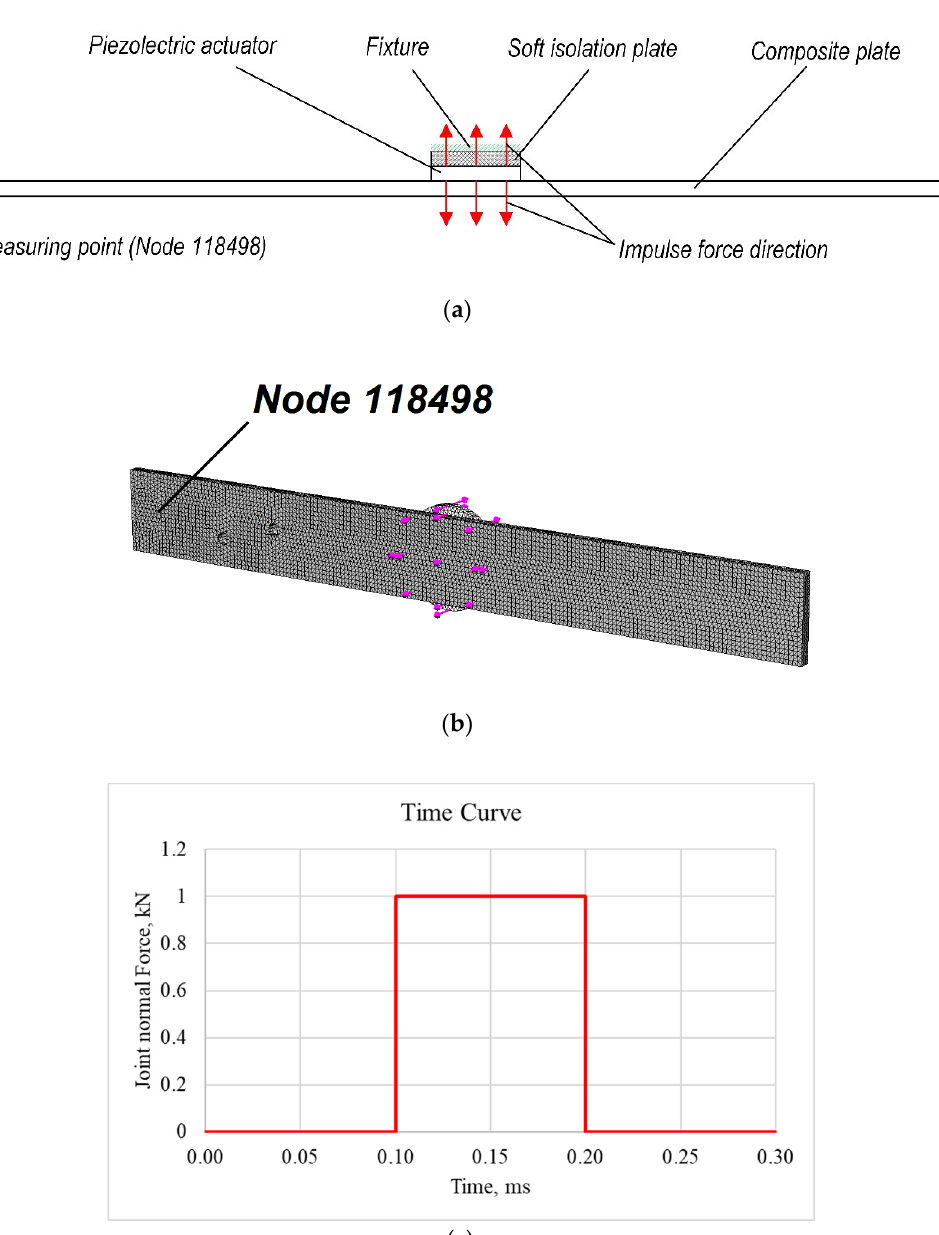
Figure 4. Modeling of the composite plate: ( a ) Schematic representation of boundary conditions used in simulation; ( b ) Computational model with boundary conditions; ( c ) Time response of the excitation impulse force.